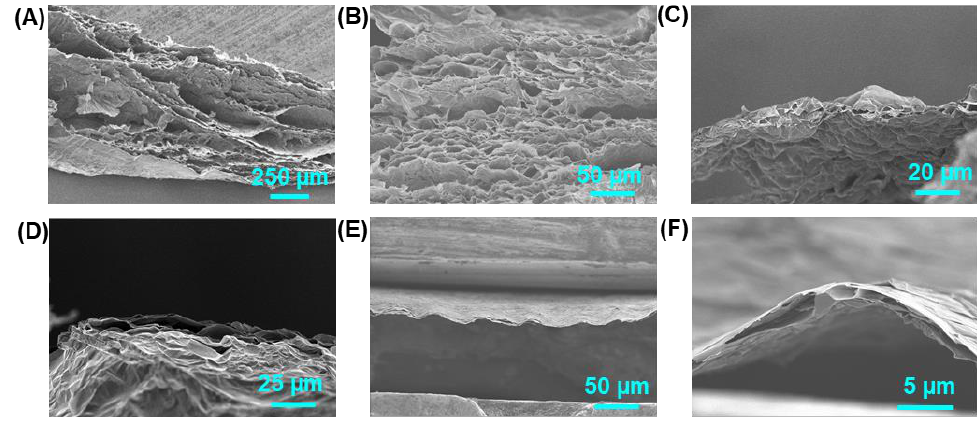
Figure 3. SEM images of cross-sections of GAFs with thicknesses of ( A , B ) 1 mm, ( C , D ) 20 µm, and ( E , F ) 3 µm.